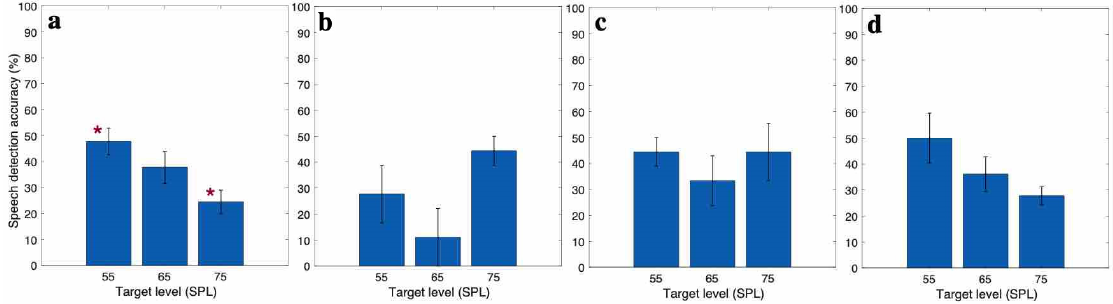
Figure 4. Speech detection accuracy for CI subjects in the case of ( a ) EH, ( b ) AH, and ( c ) EAH CI listeners and ( d ) NH listeners, (asterisks (*) show the significant difference between the corresponding accuracies).